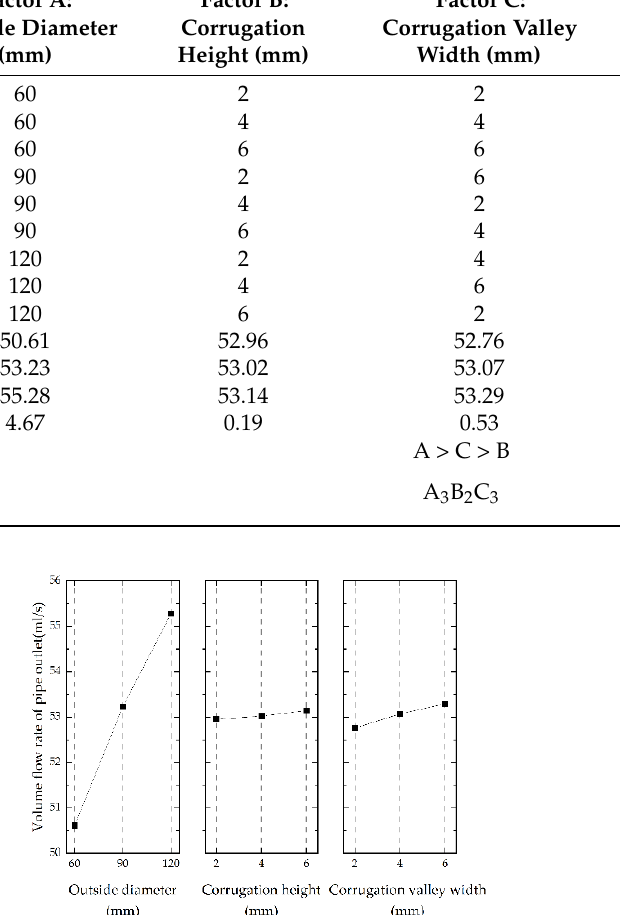
Table 7. ANOVA of the volume flow rate of the drainpipe.